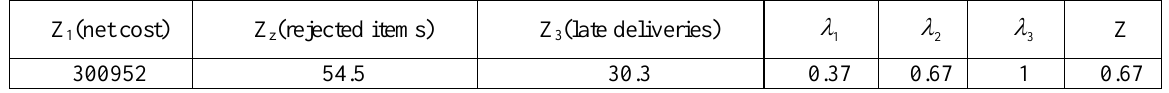
= 0.28, 𝑤 = 0.18, 𝑤 = 0.54 1 2 2